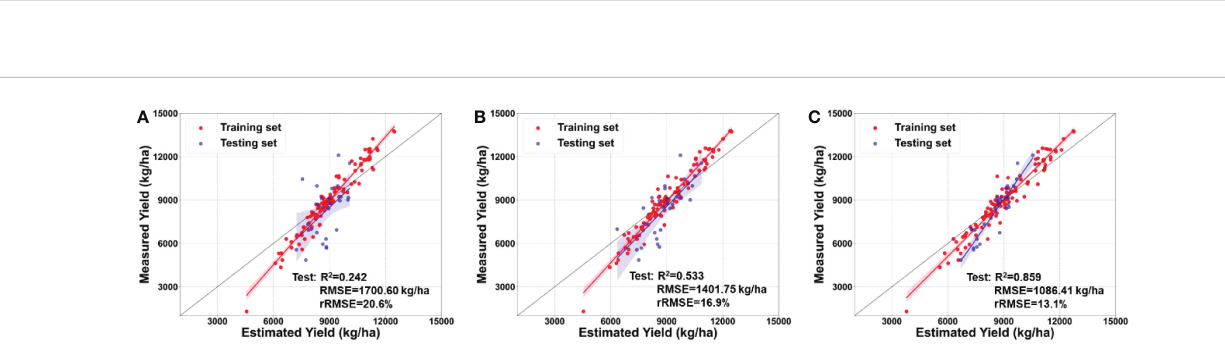
FIGURE 11 Maize yield estimated by integrating multimodal data with lodging index at the (A) tasseling stage (VT), (B) milking stage (R3), and (C) denting stage (R5).